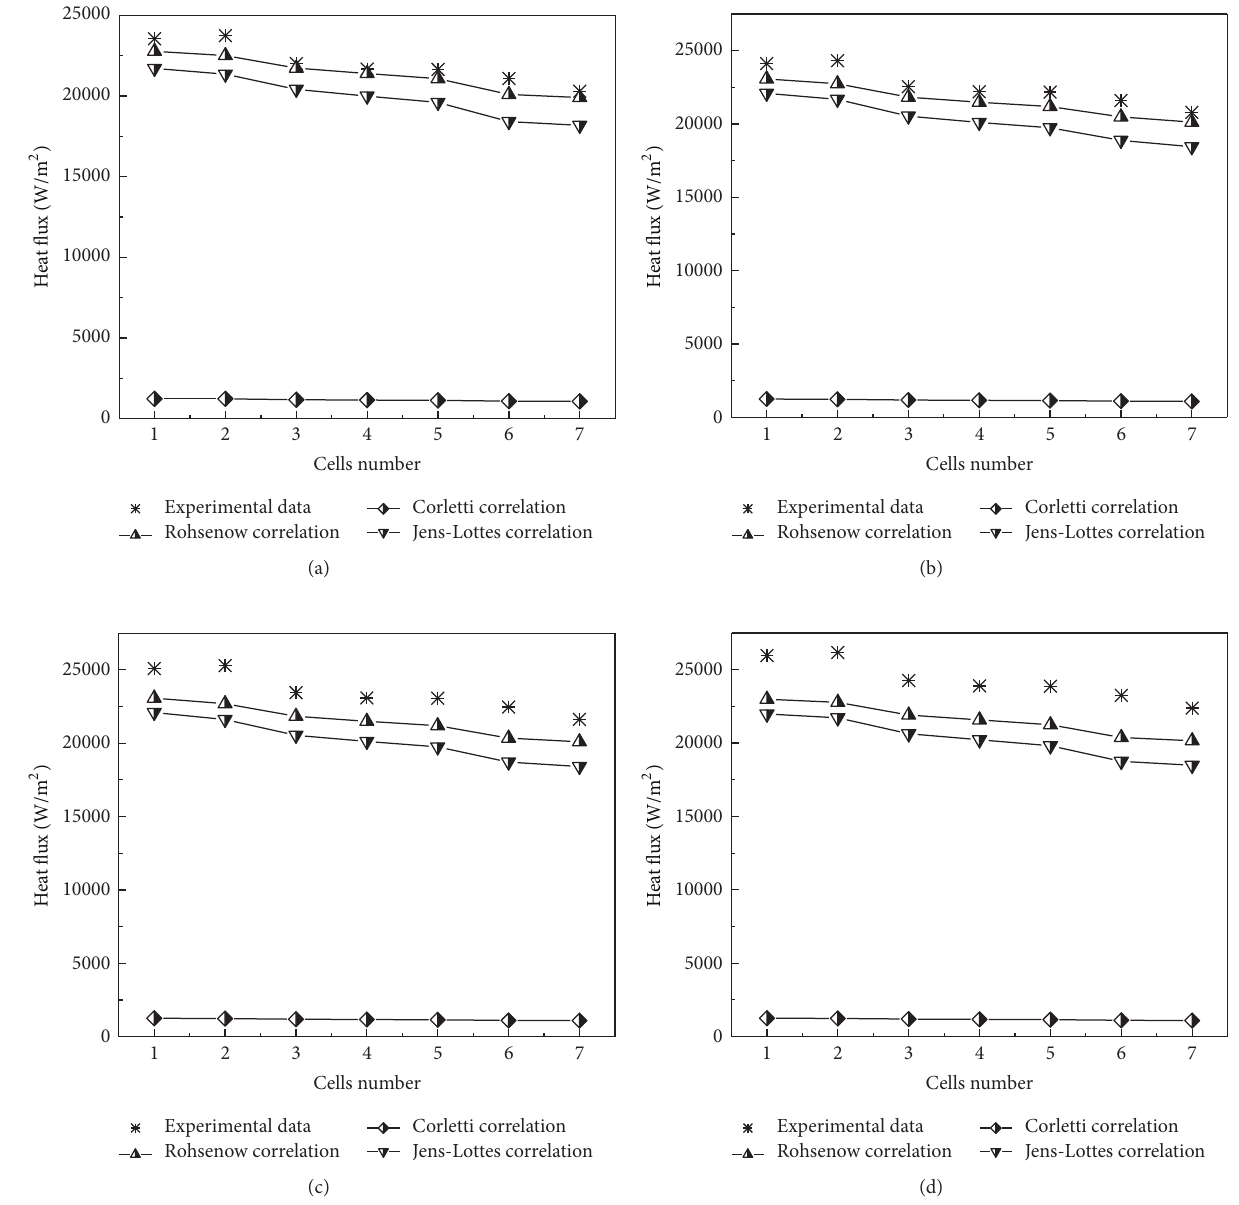
Figure 7: Comparison of heat flux at different times. (Here the cells number was divided by using tube wall thermocouples position as cells boundary.) (a) 15000s; (b) 15500 s; (c) 16000 s; (d) 16500 s.